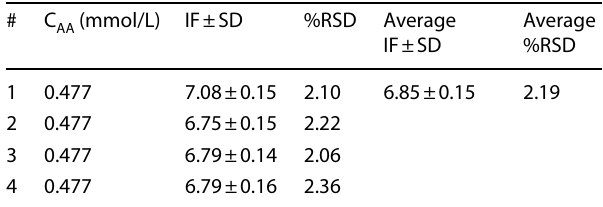
Table 4 Precision and repeatability estimation results for one standard AA